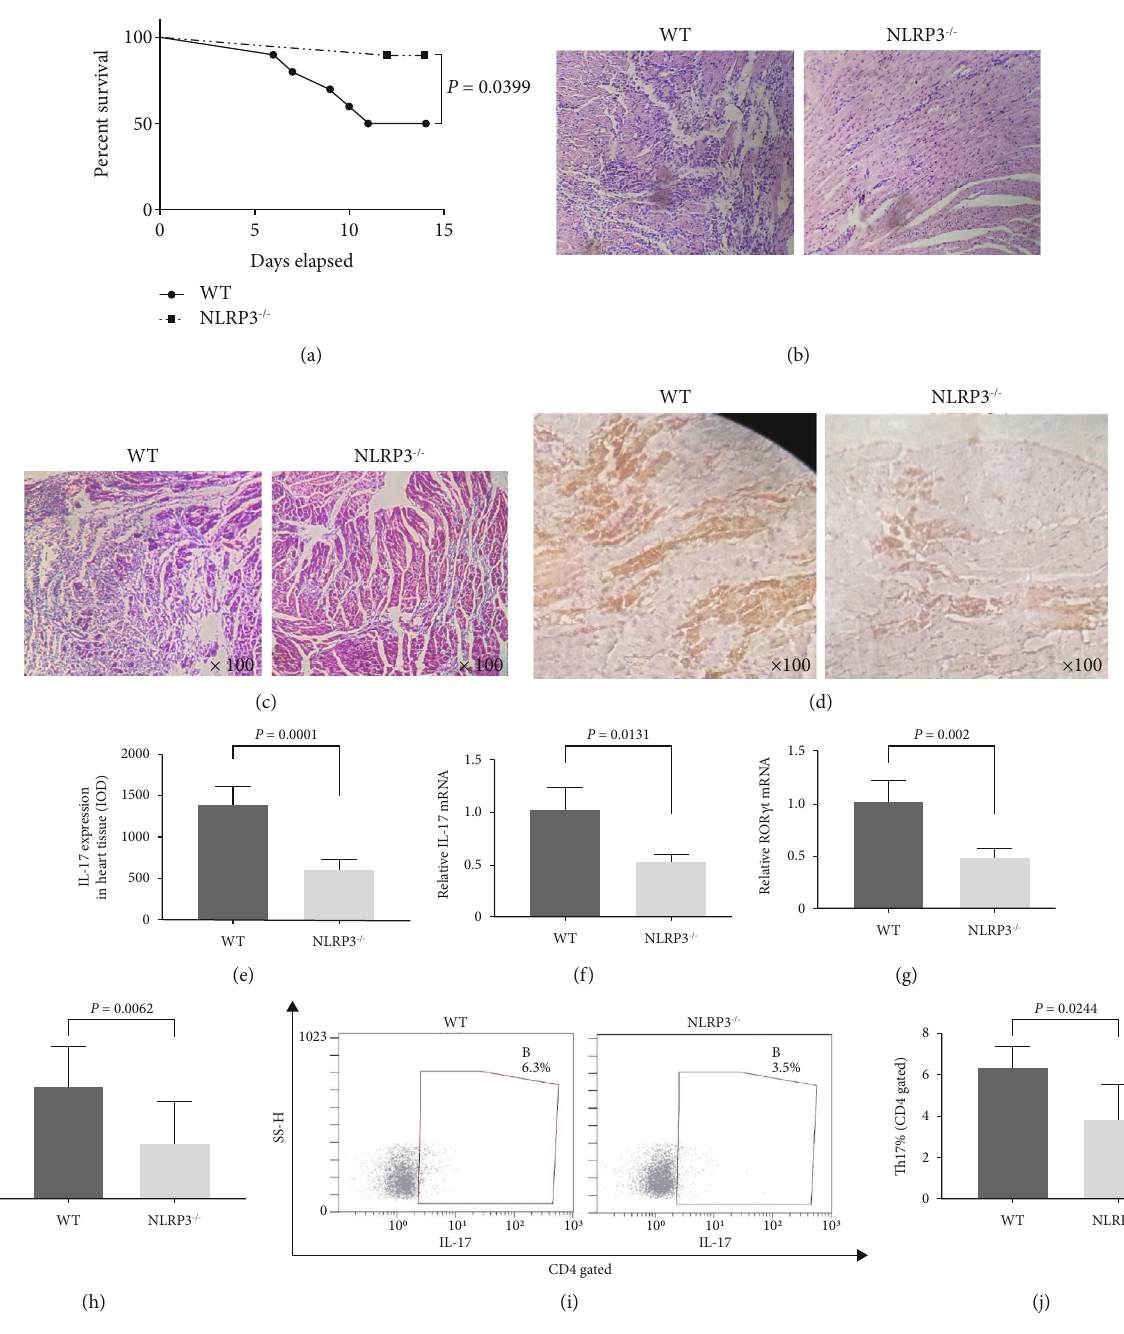
Figure 7: Knockout of NLRP3 signi fi cantly alleviates the severity of CVB3-induced VMC in Balb/c. (a) Statistical analysis of survival rate from day zero to day fourteen in WT and NLRP3 -/- group. (b) HE images of myocardial in WT and NLRP3 -/- groups at fourteenth day of CVB3-induced VMC process (original magni fi cation × 100 and × 200). (c) Masson-trichrome staining of myocardial in WT and NLRP3 -/- groups at fourteenth day of CVB3-induced VMC process (original magni fi cation × 100). (d) IHC images of IL-17 in myocardial in WT and NLRP3 -/- groups at fourteenth day of CVB3-induced VMC process (original magni fi cation × 100). (e) IL-17 expression in heart tissue acquired by IHC assay and IOD value was calculated by Image-Pro Plus. (f, g) The relative mRNA expression of IL-17 and ROR γ t in myocardium in WT and NLRP3 -/- groups at fourteenth day of CVB3-induced VMC process. (h) The protein level of IL-17 in plasma in WT and NLRP3 -/- groups at fourteenth day of CVB3-induced VMC process. (i) The proportion of Th17 cells in spleen samples in WT and NLRP3 -/- groups at fourteenth day of CVB3-induced VMC process. (j) Statistical histogram of Th17 proportion in (i). Statistical description: the P value in the fi gure has been marked between the corresponding